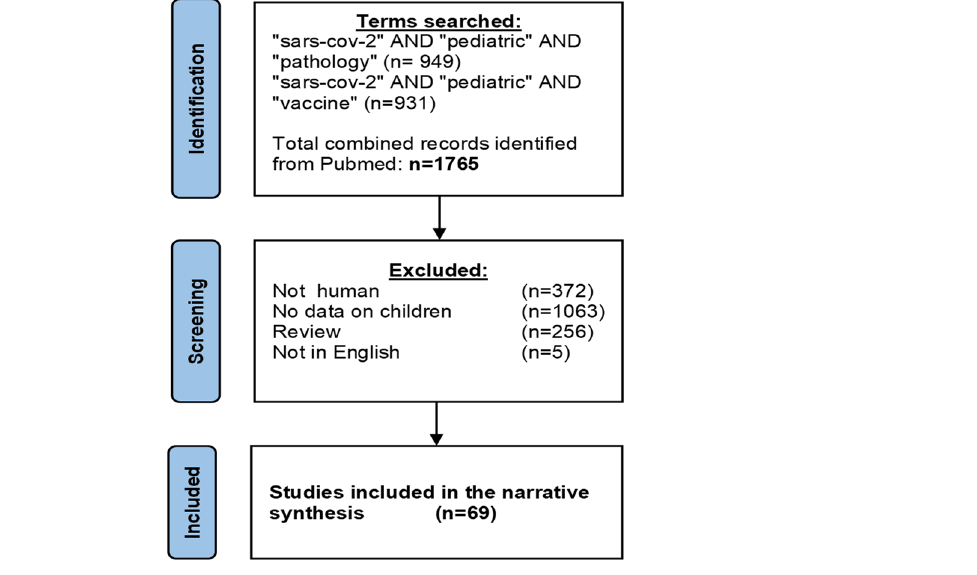
Figure 1. A PRISMA diagram illustrating the criteria for inclusion of original research publications that were included in the narrative synthesis of this review.